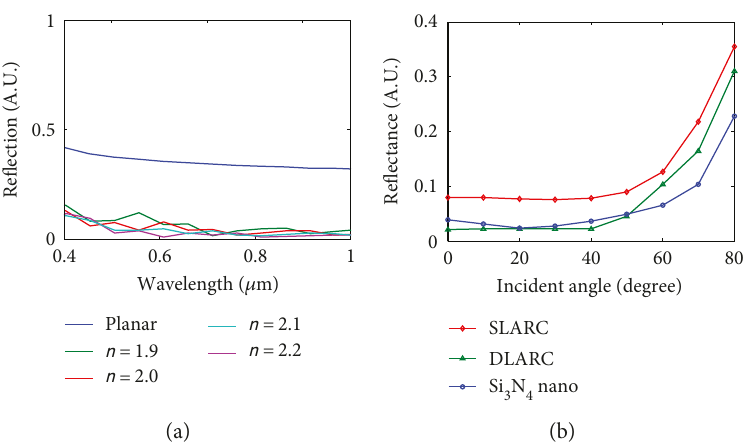
Figure 2: Simulated antire fl ection properties of SiN NDL. (a) Spectral re fl ectance of SiN NDL with refractive index from 1.9 to 2.1 and x x normal incident light from 300nm to 900nm. (b) Simulation result of integrated overall angular re fl ectance under AM 1.5G of SLARC (red), DLARC (green), and SiN NDL with re fl ective index of 2.1 (blue). x